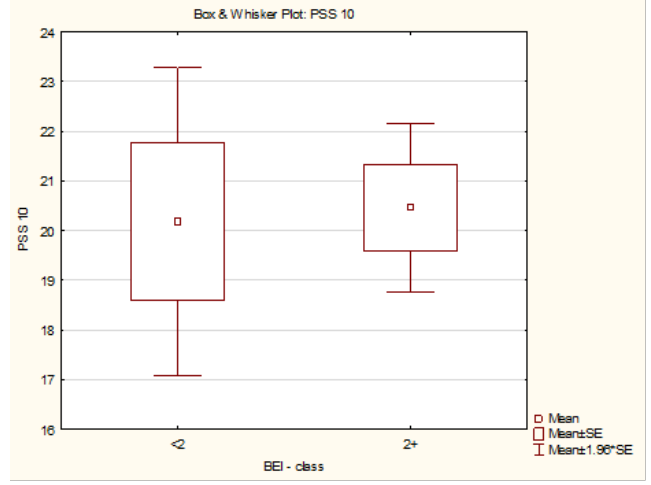
Figure 2. Summary of the PSS-10 scores for the studied and control